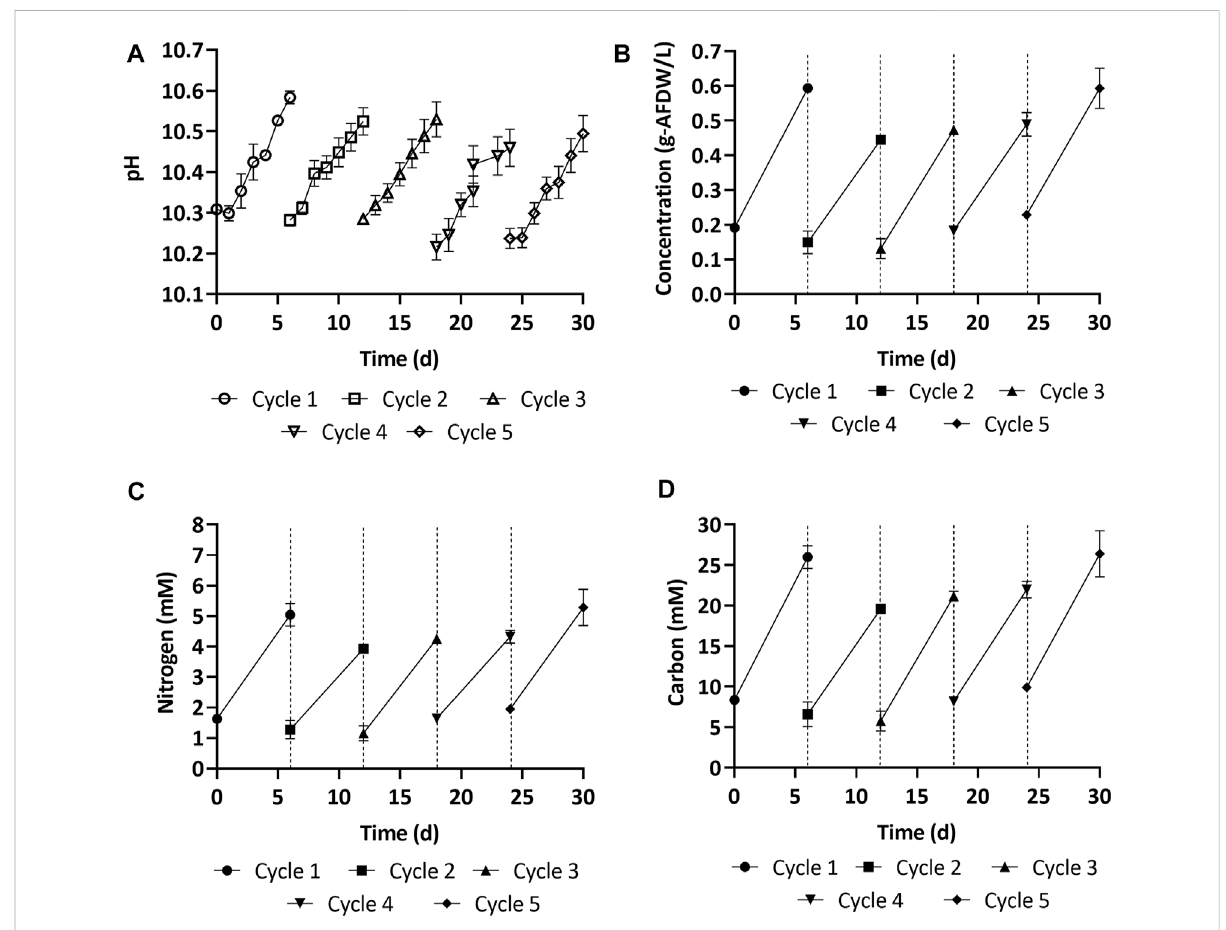
FIGURE 6 (A , B) Biomass growth and pH overtime in the fresh (cycle 1) and spent medium (cycle 2 – 5). (C , D) Nitrogen and carbon accumulated in the biomass overtime in the fresh (cycle 1) and spent medium (cycle 2 – 5). Error bars represent the standard deviation of the triplicate samples for each time point. The dashed vertical lines represent the transition between one growth cycle and the next.